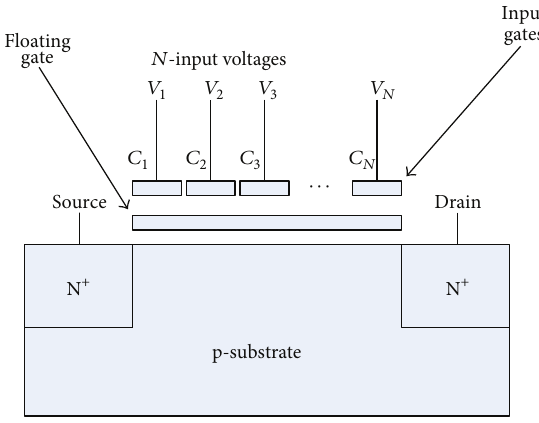
Figure 1: A cross-sectional view of N-type 𝑁 inputs FGMOSFET